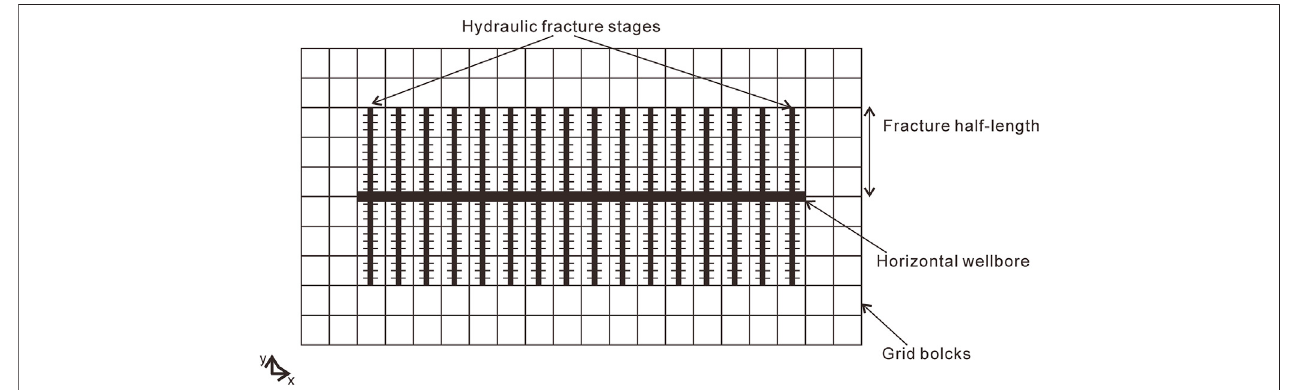
FIGURE 2 | Top view of the numerical simulation model.